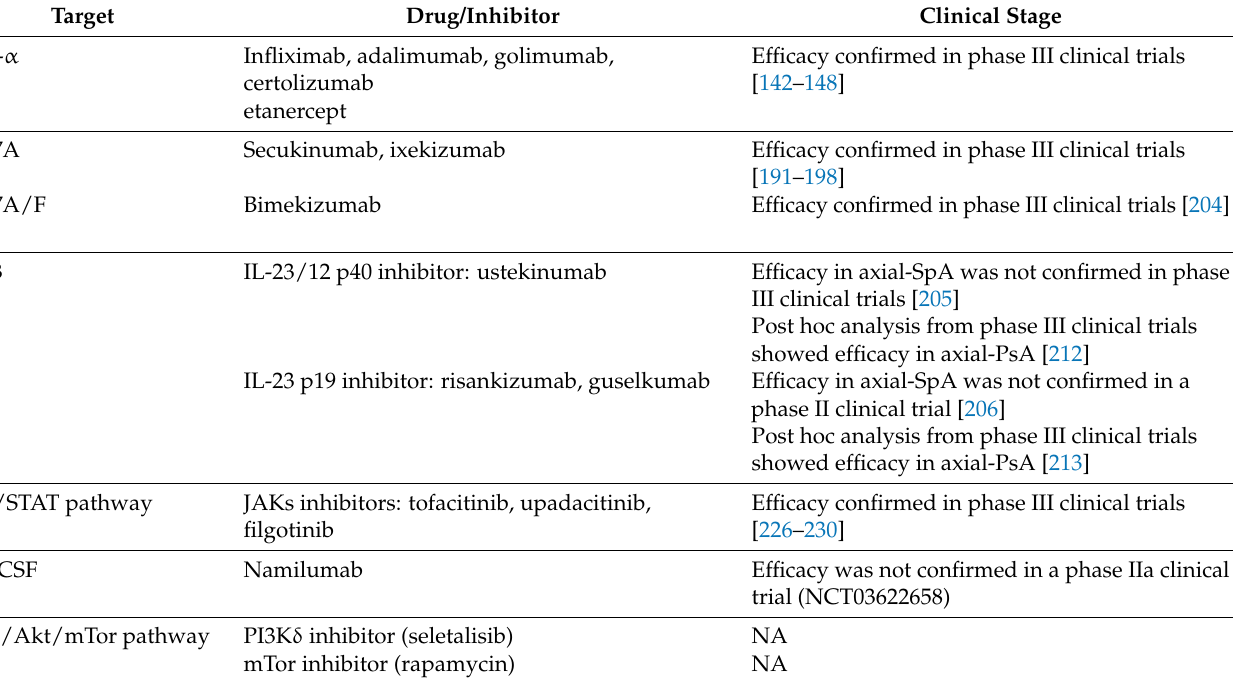
Table 1. Mechanism of action and clinal stage of new and potential therapeutic targets in